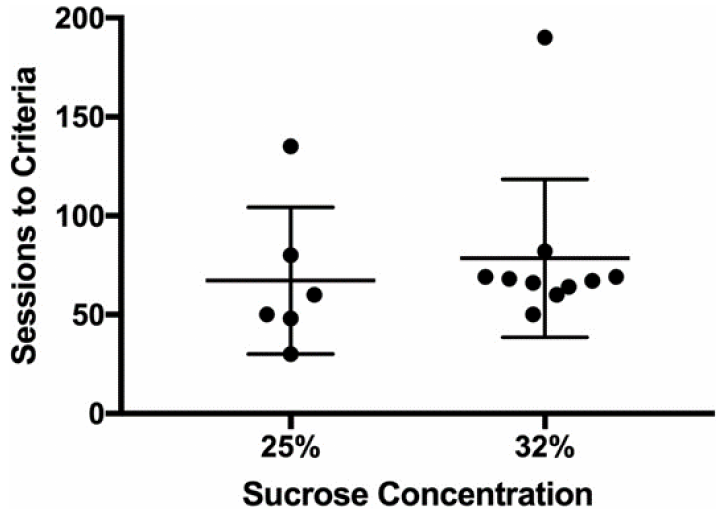
Figure 1. Effect of sucrose solution concentration on acquisition of the discrimination between 3.2 NTX and saline. Filled symbols represent individual subject sessions to discrimination criteria. The long horizontal line represents the mean sessions to criteria and the shorter horizonal line represents SEM. No significant differences between the concentrations were noted.